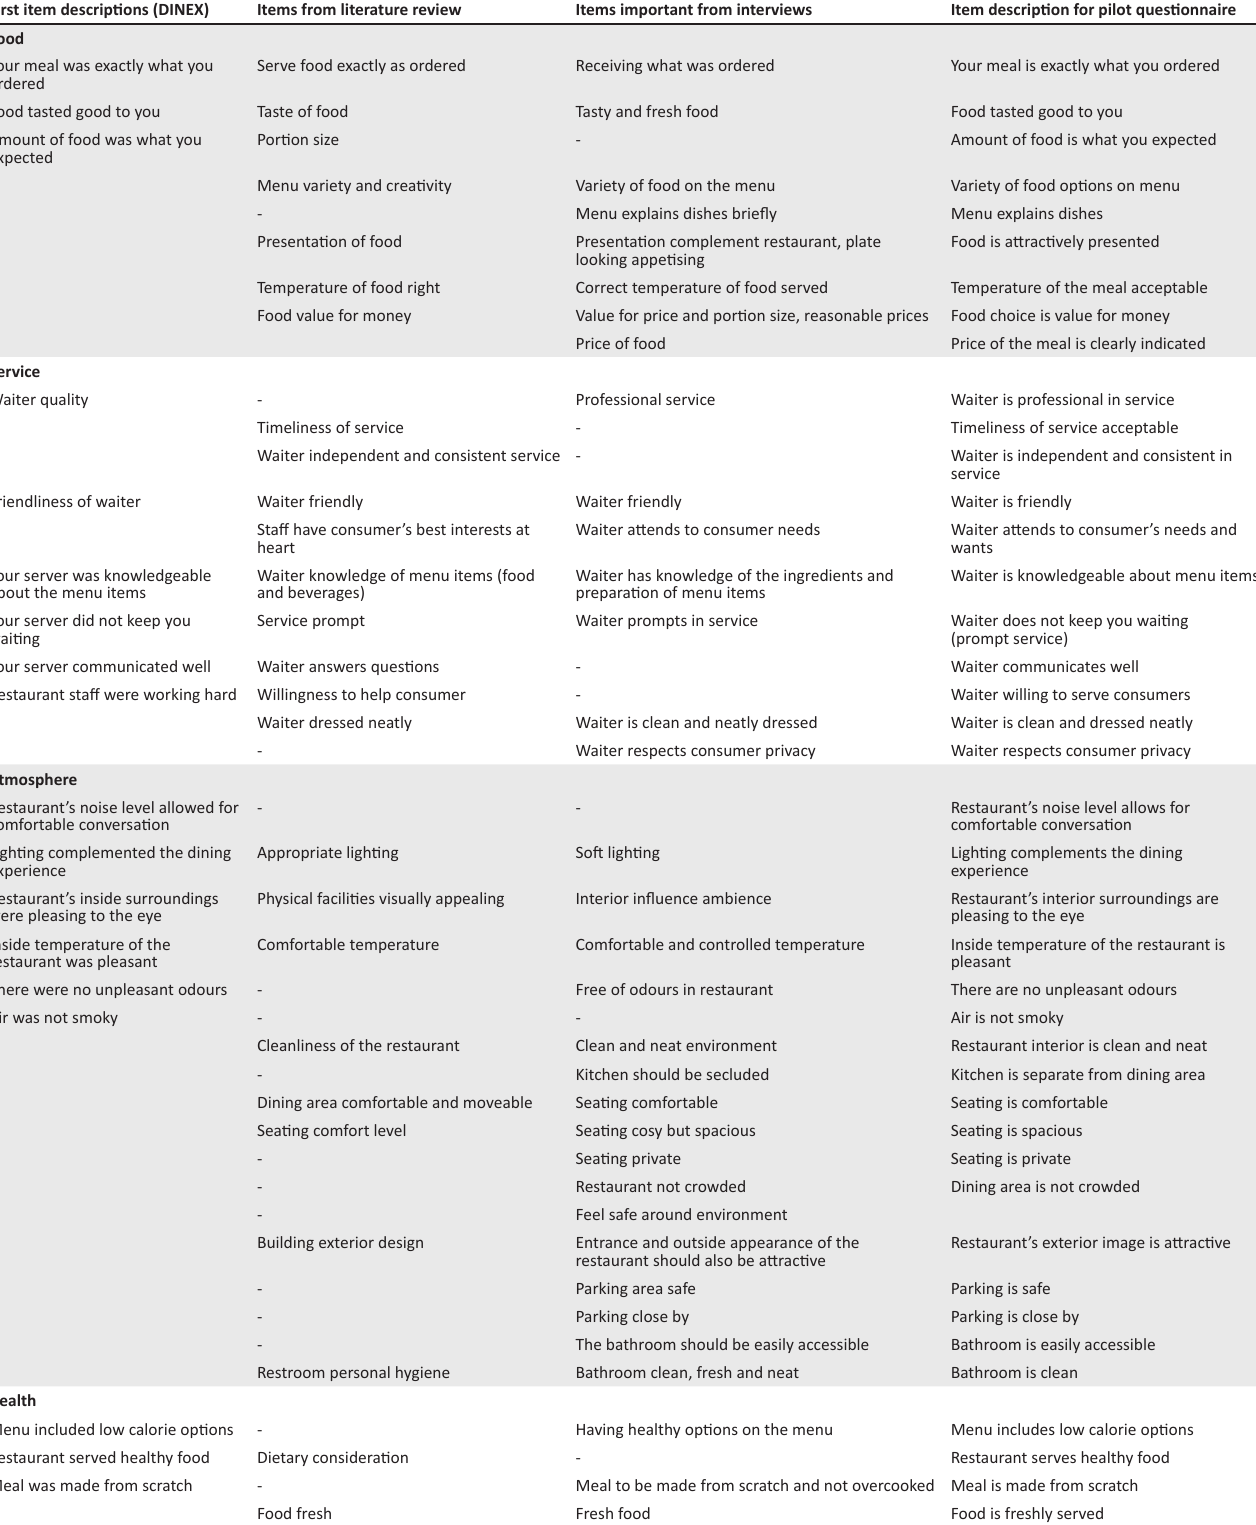
TABLE 1 : Stages of item identification and description of important dining experience